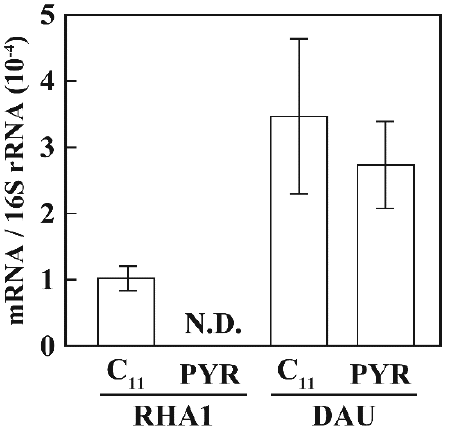
Figure 5. qRT-PCR analysis of the expression of alkB in RHA1 and DAU. The cells of RHA1 and DAU were grown in W medium containing 10 mM n -undecane (C11) or 20 mM pyruvate (PYR). Values for each mRNA expression were normalized to 16S rRNA gene expression. The data are mean values ± standard deviations for three independent experiments. N.D.: Not detected.